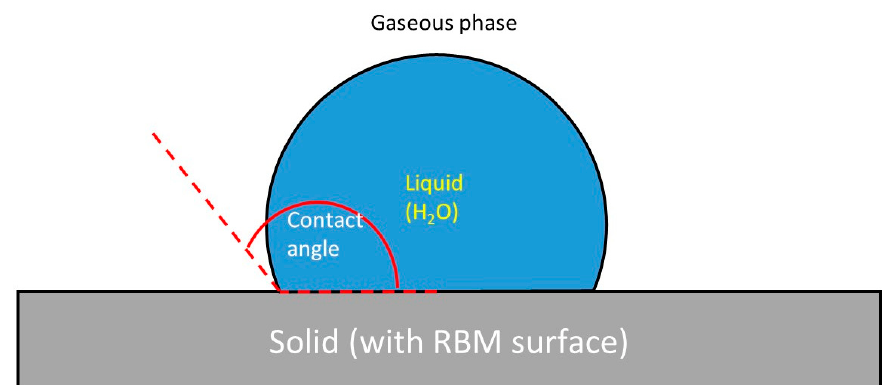
Figure 1. The wettability of a surface depends on the surface energy of the solid, the surface tension of the liquid, and the gaseous phase. Wettability can be established by measuring the contact angle between the liquid and the solid.